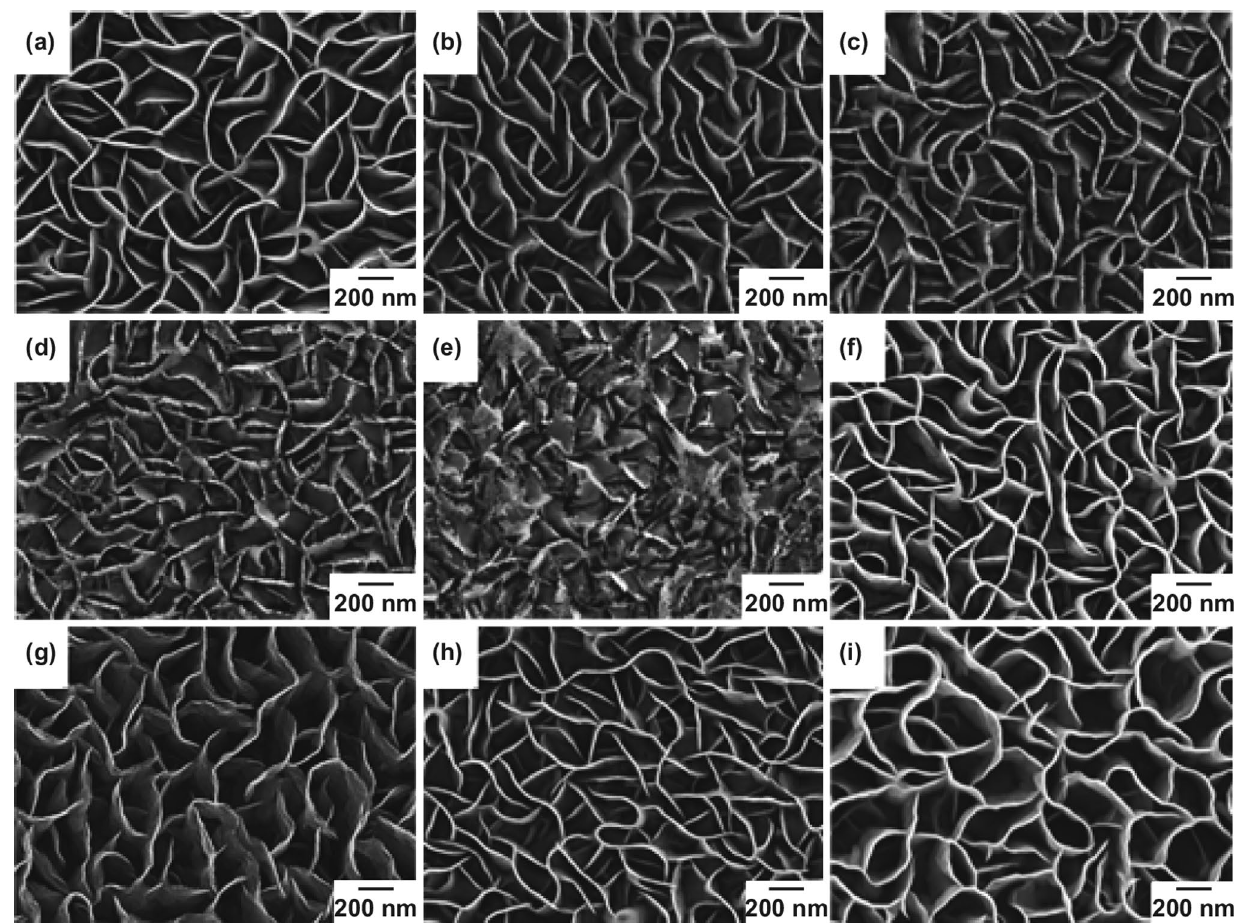
Fig. 2 SEM images of a nontreated CNWs, b – e 10 s, 20 s, 30 s, and 40 s of N 2 plasma-treated CNWs, f – i 4 s, 8 s, 12 s, and 25 s of NH 3 plasma-treated